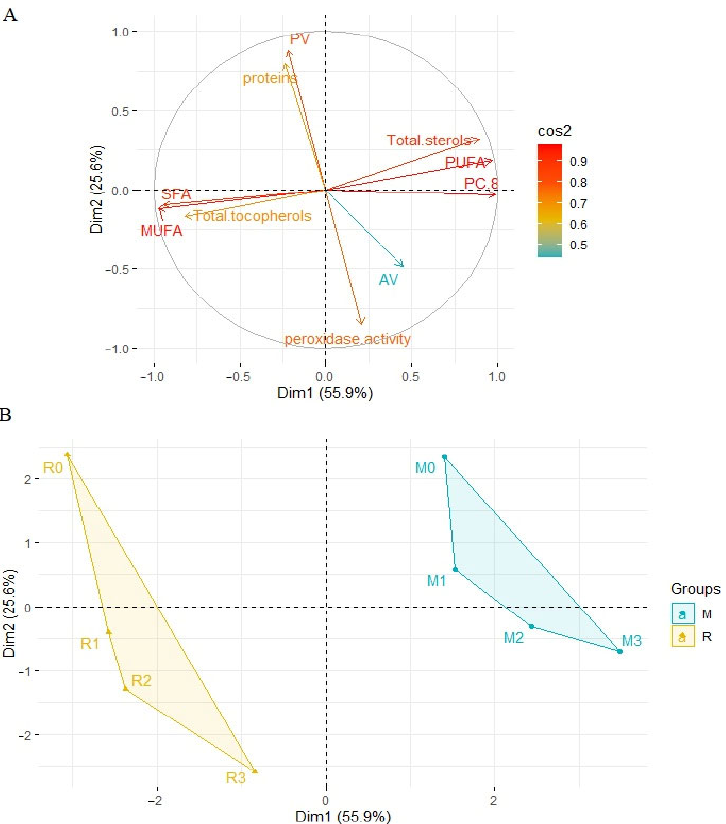
Figure 9. Principal component analysis (PCA) of the loading plot ( A ) and the score plot ( B ) of data from SFA, MUFA, PUFA, total sterols and tocopherols content, plastochromanol-8 (PC-8), peroxide value, acid value in rapeseed and mustard seed oils, and proteins content and peroxidase activity in rape and mustard seeds. M—mustard samples, R—rape samples, 1, 2, 3—days of germination of seeds.